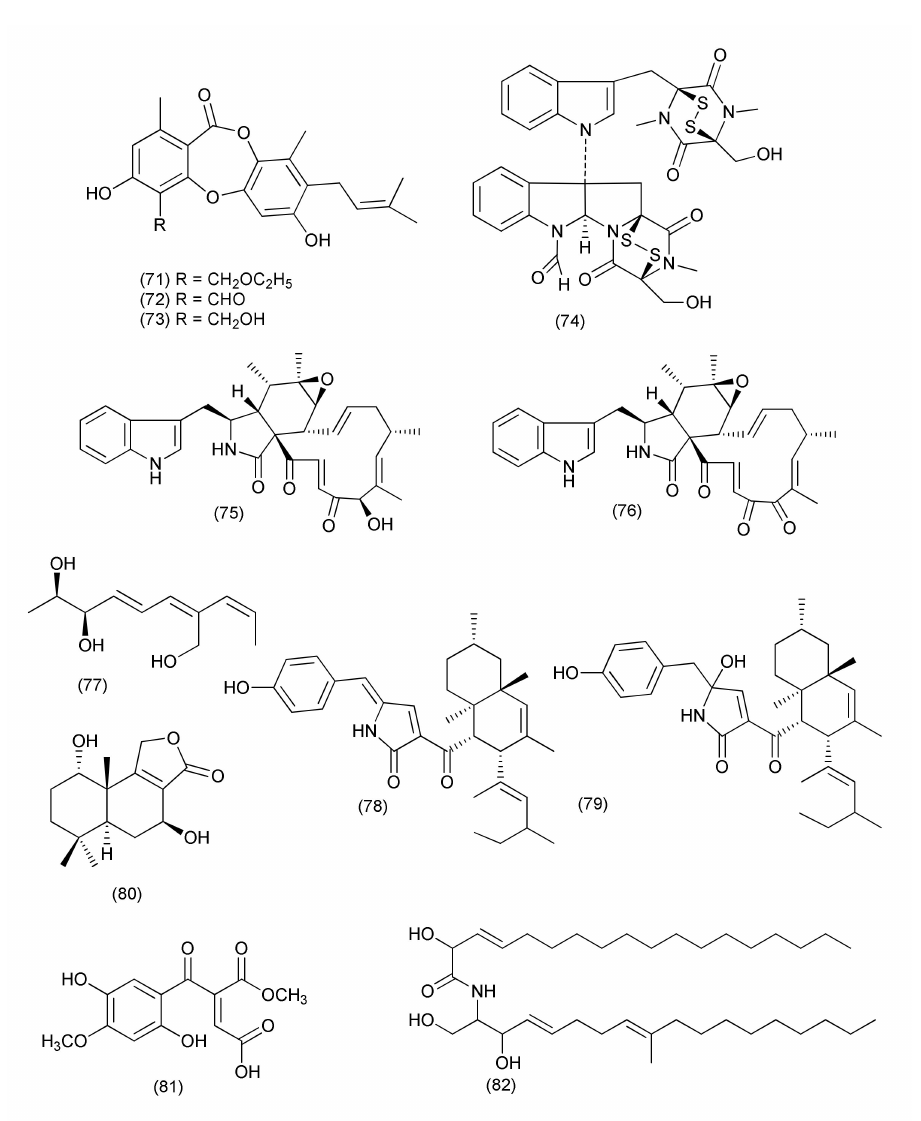
Figure 5. Structures of metabolites 71 – 82 isolated from